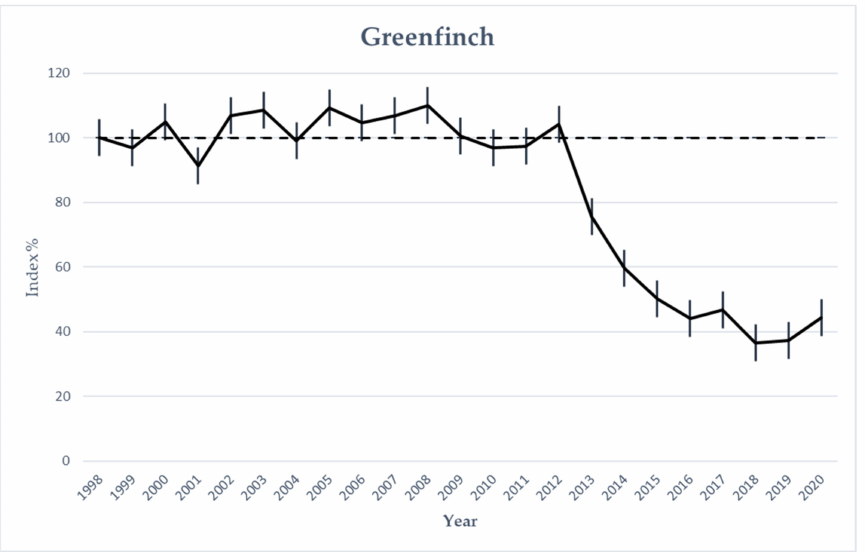
Figure 4. Graphical representation of population trend (index values and 95%-confidence limits) of the Austrian greenfinch population for the period 1998–2020 (1998 =